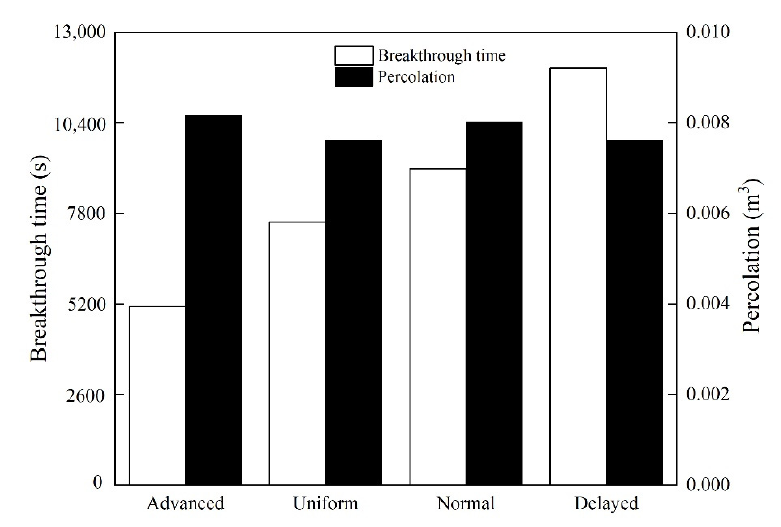
rainfall Figure 12. Breakthrough time and percolation in four rainfall patterns under relatively long rainfall duration.